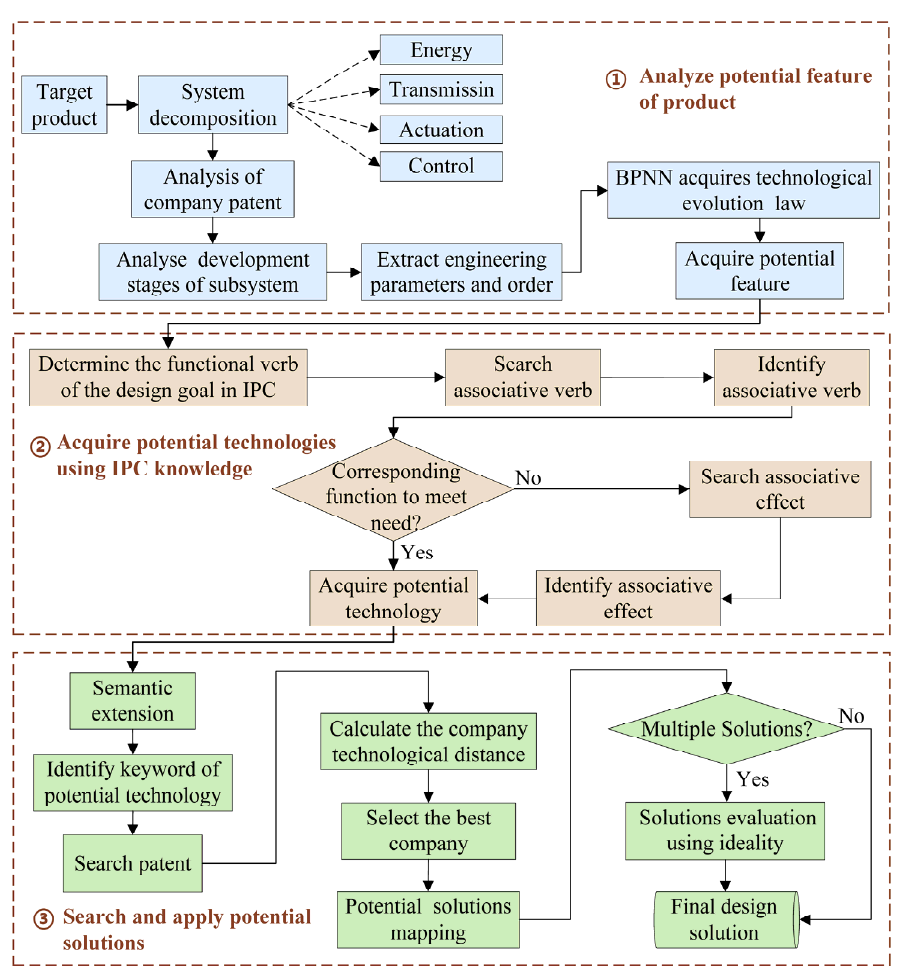
Figure 8. Framework of the proposed method.